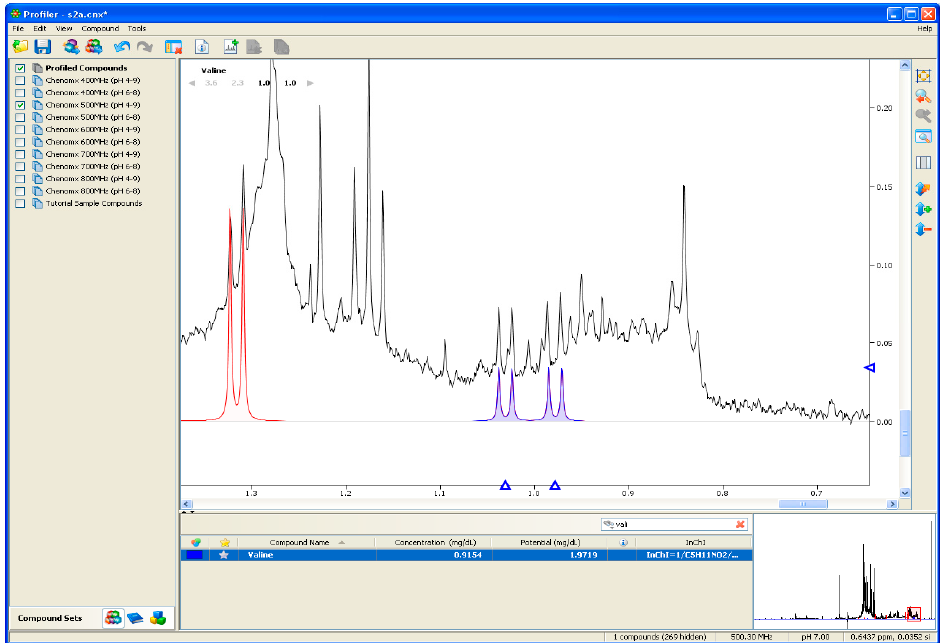
Figure 2. Section of a 1 H NMR of soil extract (black) overlaid with NMR spectra of lactate (red) and valine (blue). valine